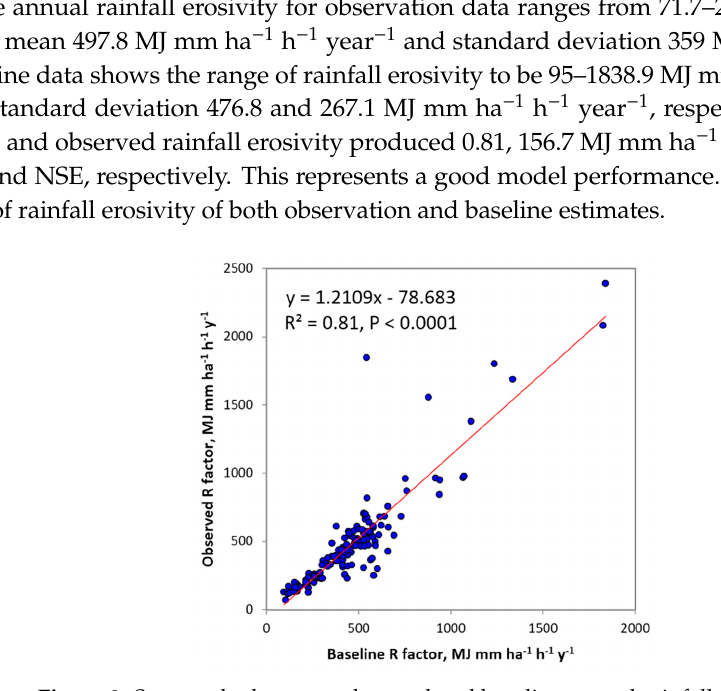
Figure 3. Scatter plot between observed and baseline annual rainfall erosivity.